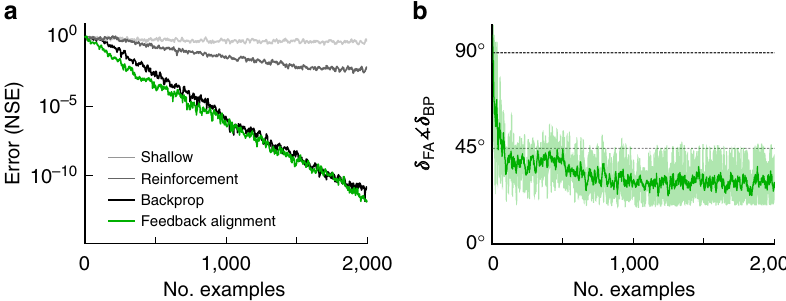
Figure 2 | Feedback alignment matches backprop performance on a linear problem. ( a ) Four algorithms learn to mimic a linear function: ‘shallow’ learning (light grey); reinforcement learning (dark grey); backprop (black); and feedback alignment (green). NSE is normalized squared error (see Methods). ( b ) The angle between modulator vectors prescribed by feedback alignment and backprop, d FA and d BP , decreases. Error bars are two s.d.’s for a sliding window of 10